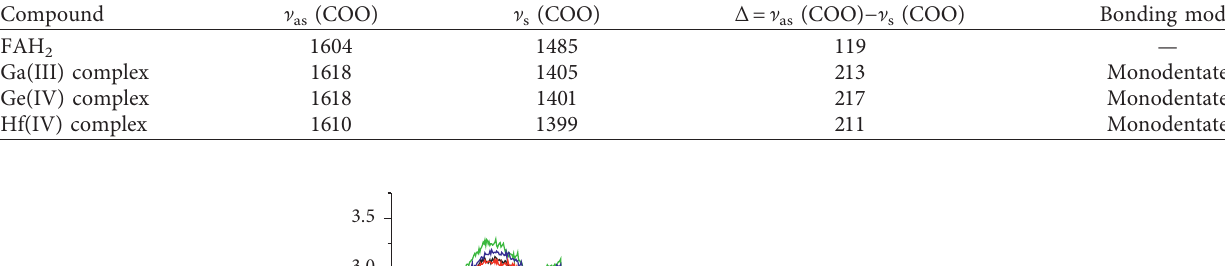
Table 2: Stretching vibration bands of the carboxylate group for the FAH